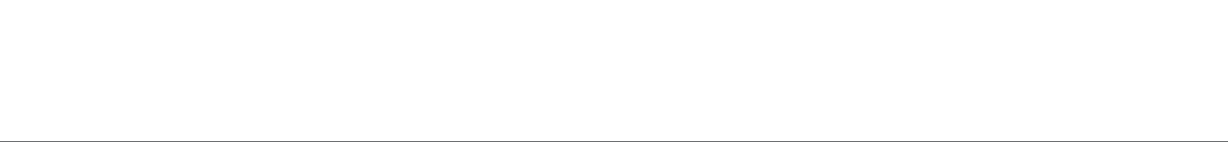
Frontiers in Chemistry |